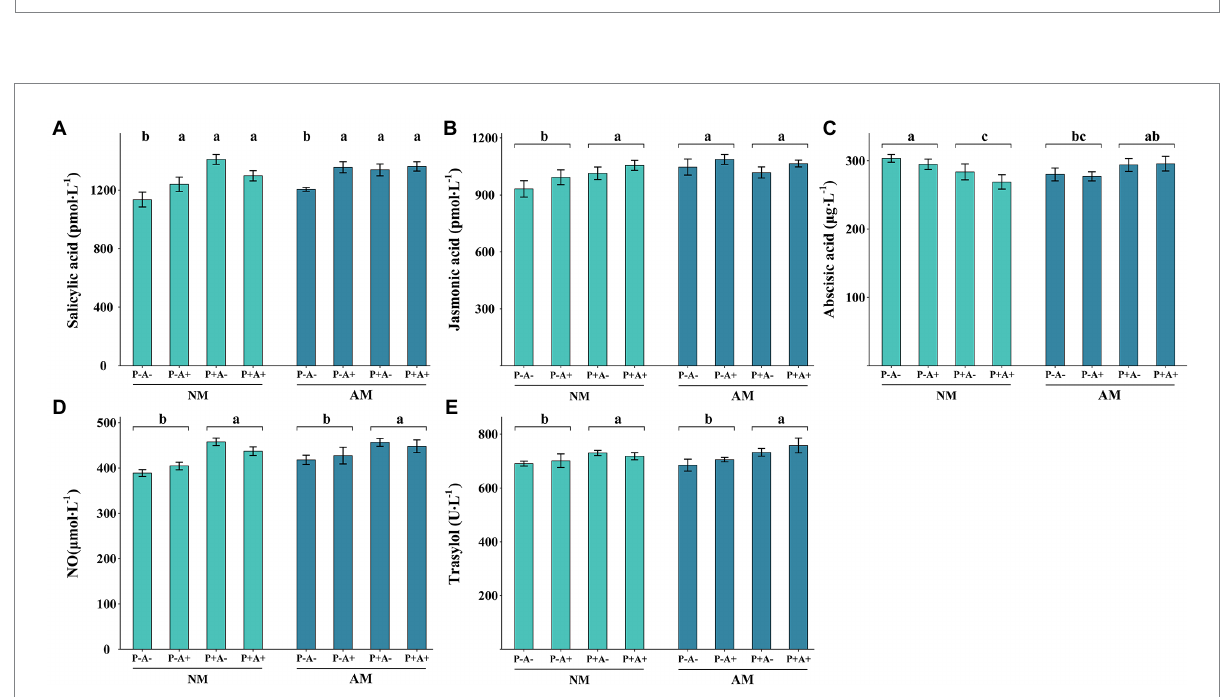
FIGURE 4 (A) SA, (B) JA, (C) ABA, (D) NO, and (E) trypsin inhibitor contents of Medicago sativa inoculated with Rhizophagus intraradices (AM), infected with Phoma medicaginis (P+), and infested with Acyrthosiphon pisum (A+), or non-inoculated with R. intraradices (NM), non-infected with